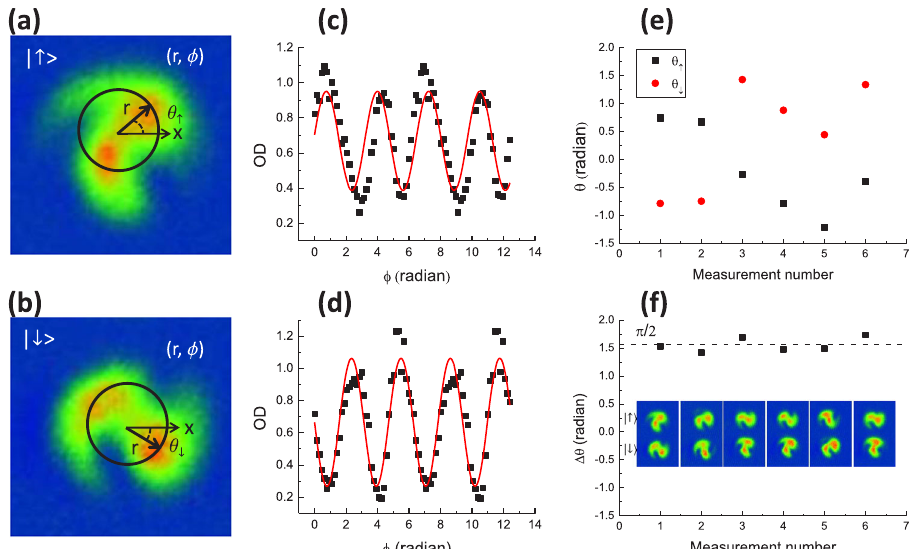
¼ 0 j i and l 1